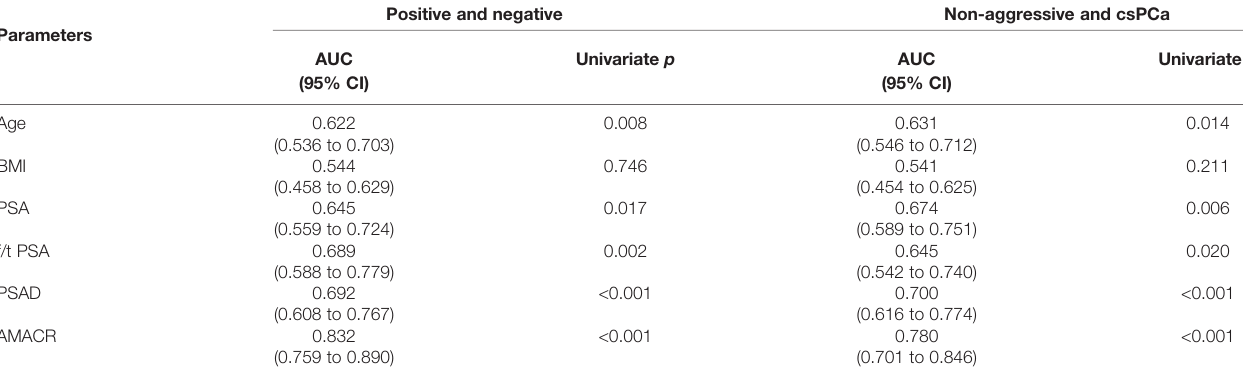
TABLE 2 | The performance of urine exosomal AMACR and clinical features to predict biopsy results in the training cohort.